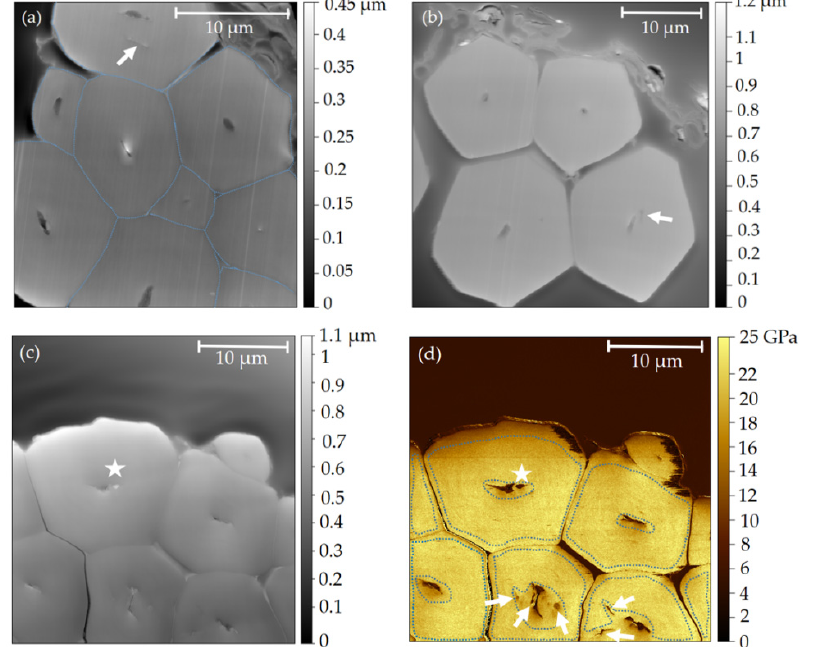
Figure 6. ( a – c ): Topographical mappings of transversal views of flax fibres obtained by Atomic Force Microscopy (AFM); ( d ): the related indentation modulus mapping of ( c ) obtained in PF-QNM mode, with selected masked areas represented by dotted lines. Arrows represent porosities and the star indicates a surface contaminant. Table 1. Mean and extremum values of fibre and lumen surface areas and related porosity content measured from 11 complete fibres on the topological mappings (Figure 6a–c).